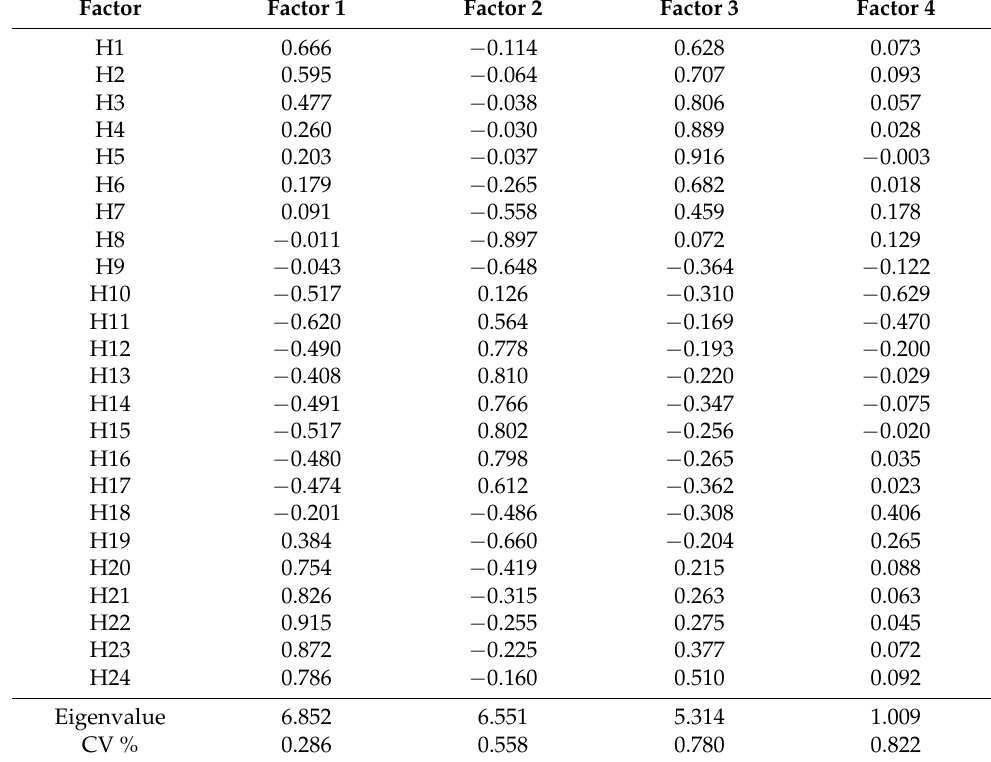
Table 2. Factor loading matrix (Varimax rotation), eigenvalues, and cumulative variance